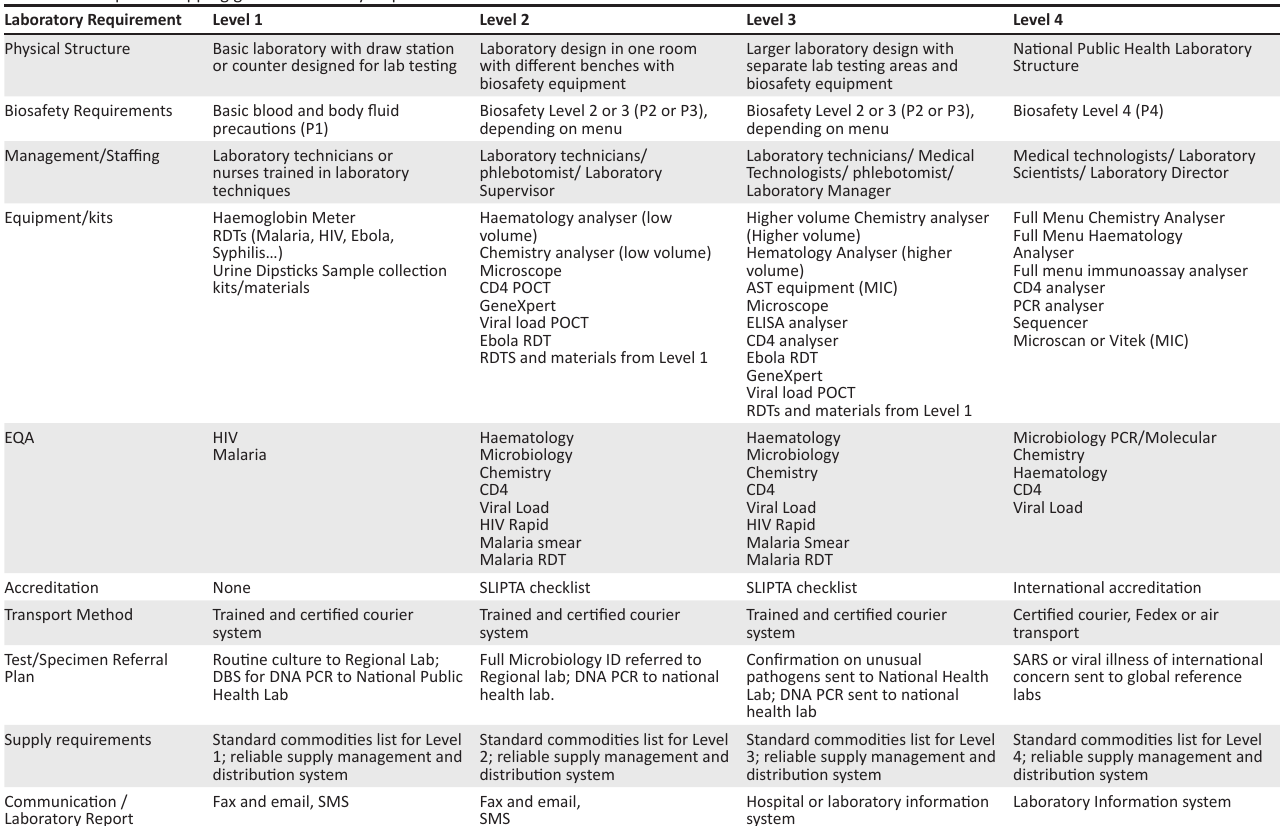
TABLE 2: Example of mapping grid of laboratory requirements for different